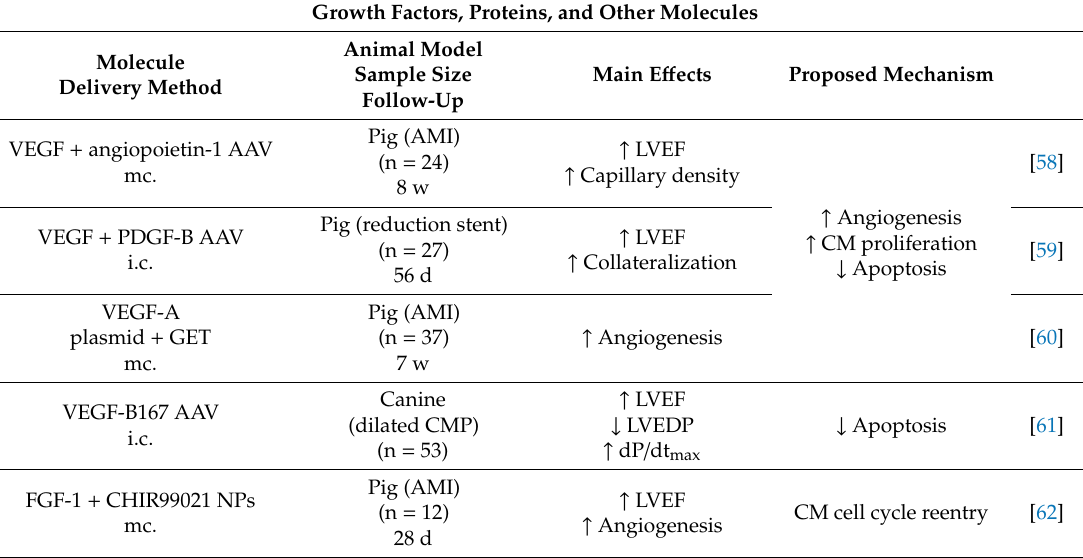
Table 3. Overview of the various large animal models of cardiac regeneration using growth factors, proteins, and other regenerative